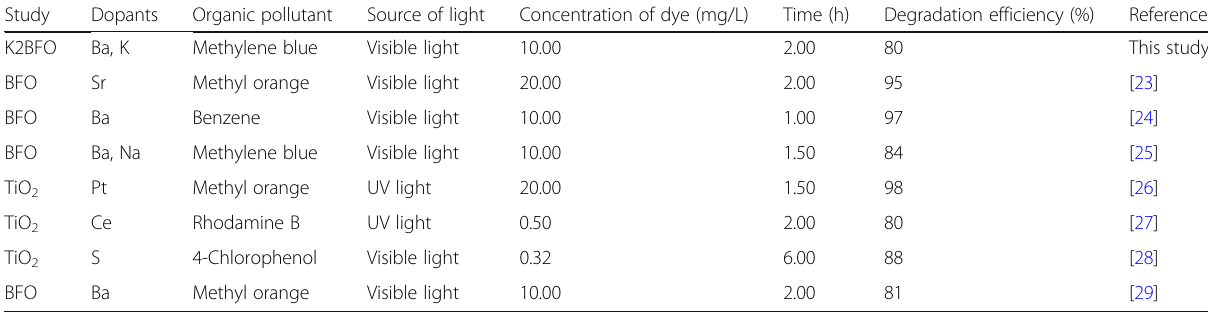
Table 3 Comparison of the rate of degradation of organic pollutants for pure BFO and BFO-doped nanoparticles using different light sources and time